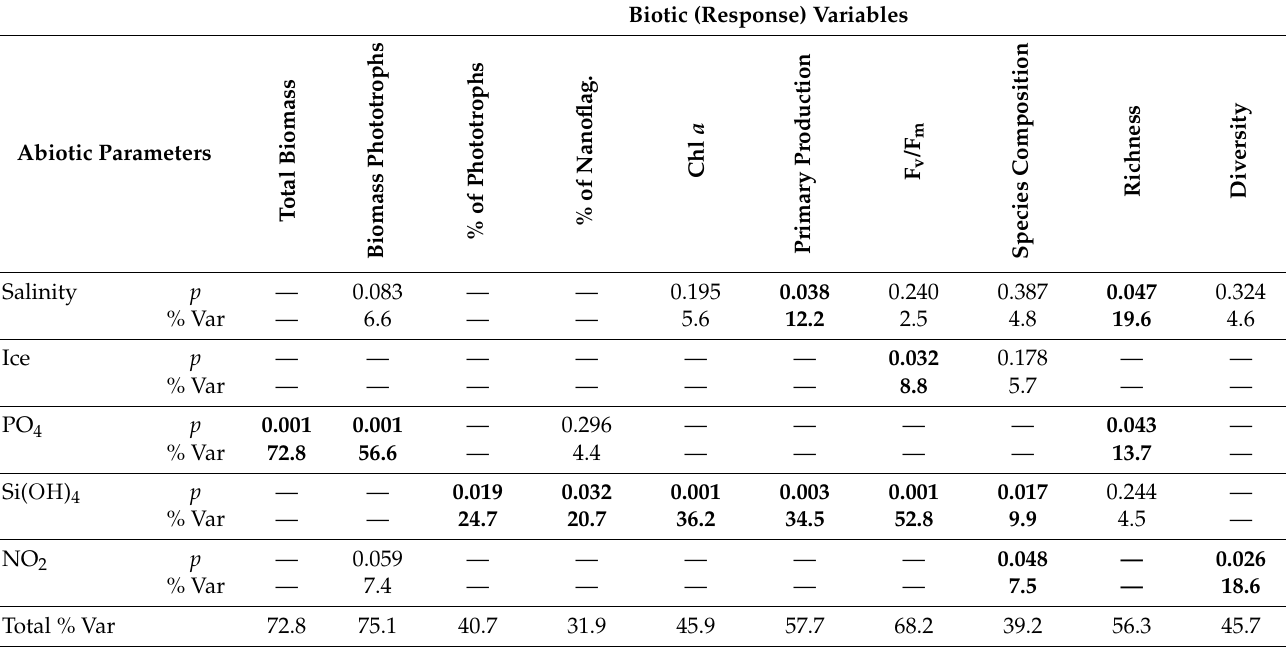
Biotic (Response)